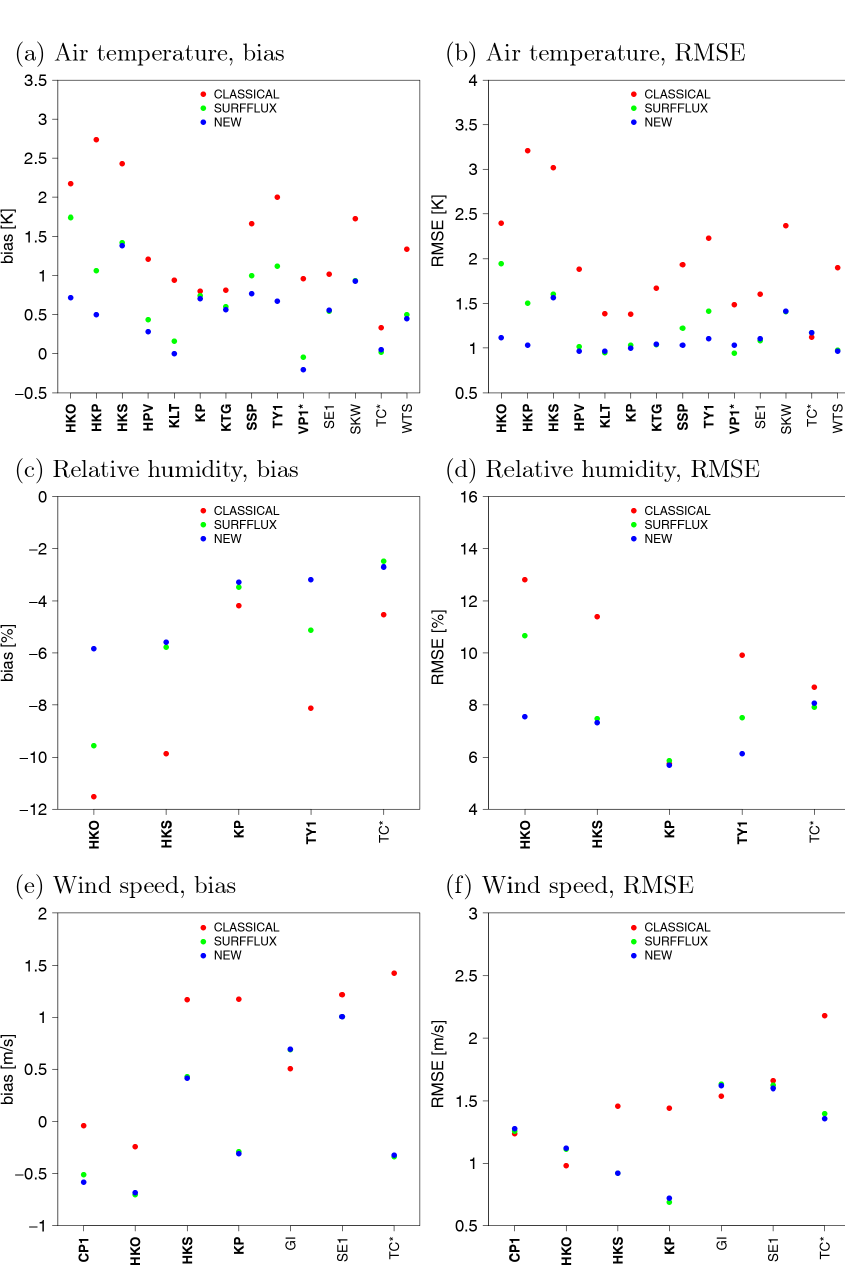
Figure B1. Model evaluation measures for hourly time series at meteorological stations in D5 and for HW2018. The urban stations are bold; the stations on mountain peaks are marked with an asterisk